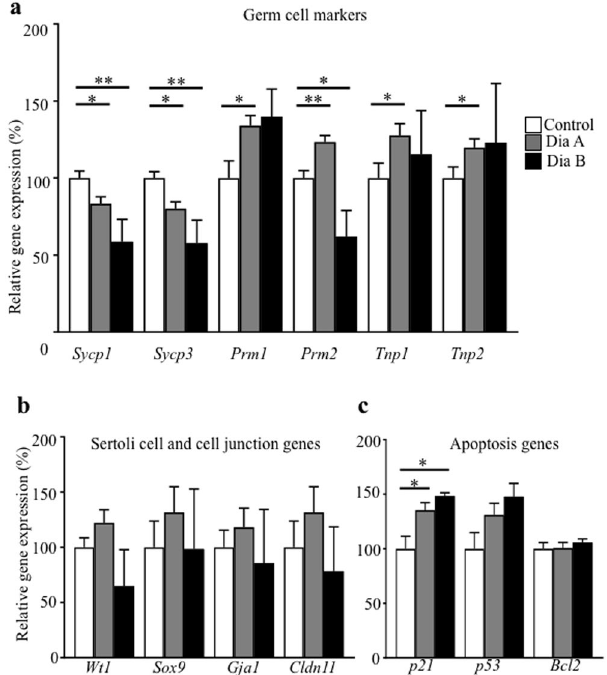
Figure 7. Gene expression changes in the testes in the parental generation. ( a ) qPCR analysis of markers for spermatogenesis and spermiogenesis: synaptonemal complex protein 1 ( Sycp1 ), synaptonemal complex protein 3 ( Sycp3 ), protamine 1 ( Prm1 ), protamine 2 ( Prm1 ), transition protein 1 ( Tnp1 ) and transition protein 2 ( Tnp2 ); ( b ) genes expressed in Sertoli cells: Wilms’ tumour 1 ( Wt1 ), SRY-box containing gene9 ( Sox9 ), gap junction protein alpha 1 ( Gja1 ) and claudin 11 ( Cldn11 ); and ( c ) apoptotic markers: cyclin-dependent kinase inhibitor 1 A ( p21 ), tumor protein p53 ( p53 ), and B cell leukemia/lymphoma 2 ( Bcl2 ). The control group represents 100% of relative gene expression. The values are means ± SEM. Control group n = 9; Dia A group n = 8; Dia B group n = 4. * P < 0.05, ** P < 0.01 vs . Control by Dunnett’s post hoc